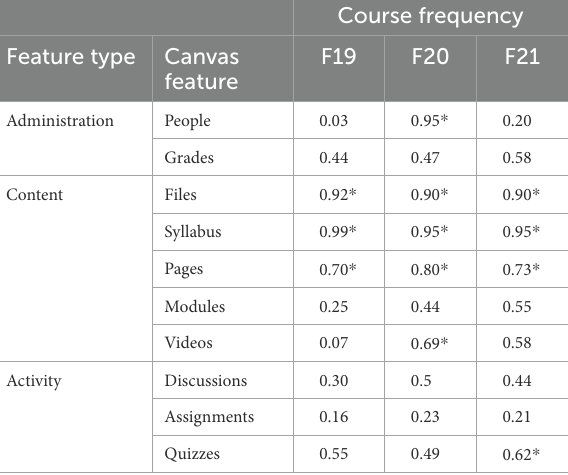
TABLE 4 Implementation rates of features per